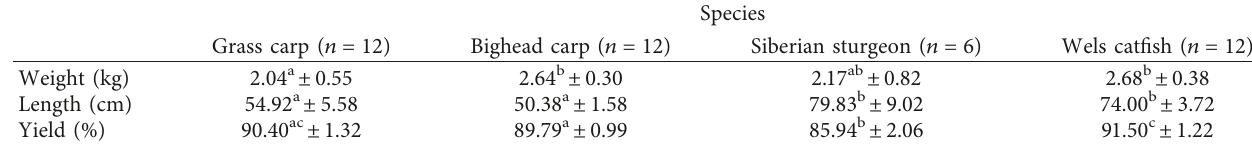
Table 1: Morphometrical measurements and yield of grass carp, bighead carp, Siberian sturgeon, and wels catfish (mean value ± SD).